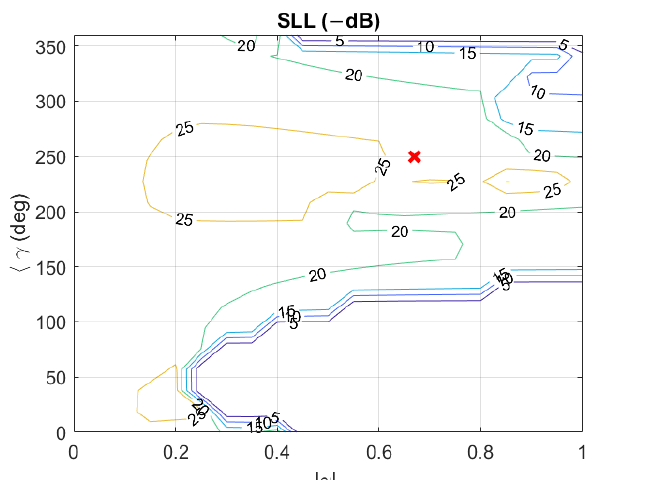
Figure 2. Iso-level curves of the antenna gain ( top ), maximum cross-polarization in the horizontal plane ( centre ) and maximum side lobe level in the horizontal plane ( bottom ) at 30 GHz as a function of the magnitude and phase of the ratio γ between the TM 11 and TE 11 modal coefficients for the circular waveguide aperture of radius 18 mm. The marker (x) is placed in correspondence of the optimized value of γ for the configuration used in this